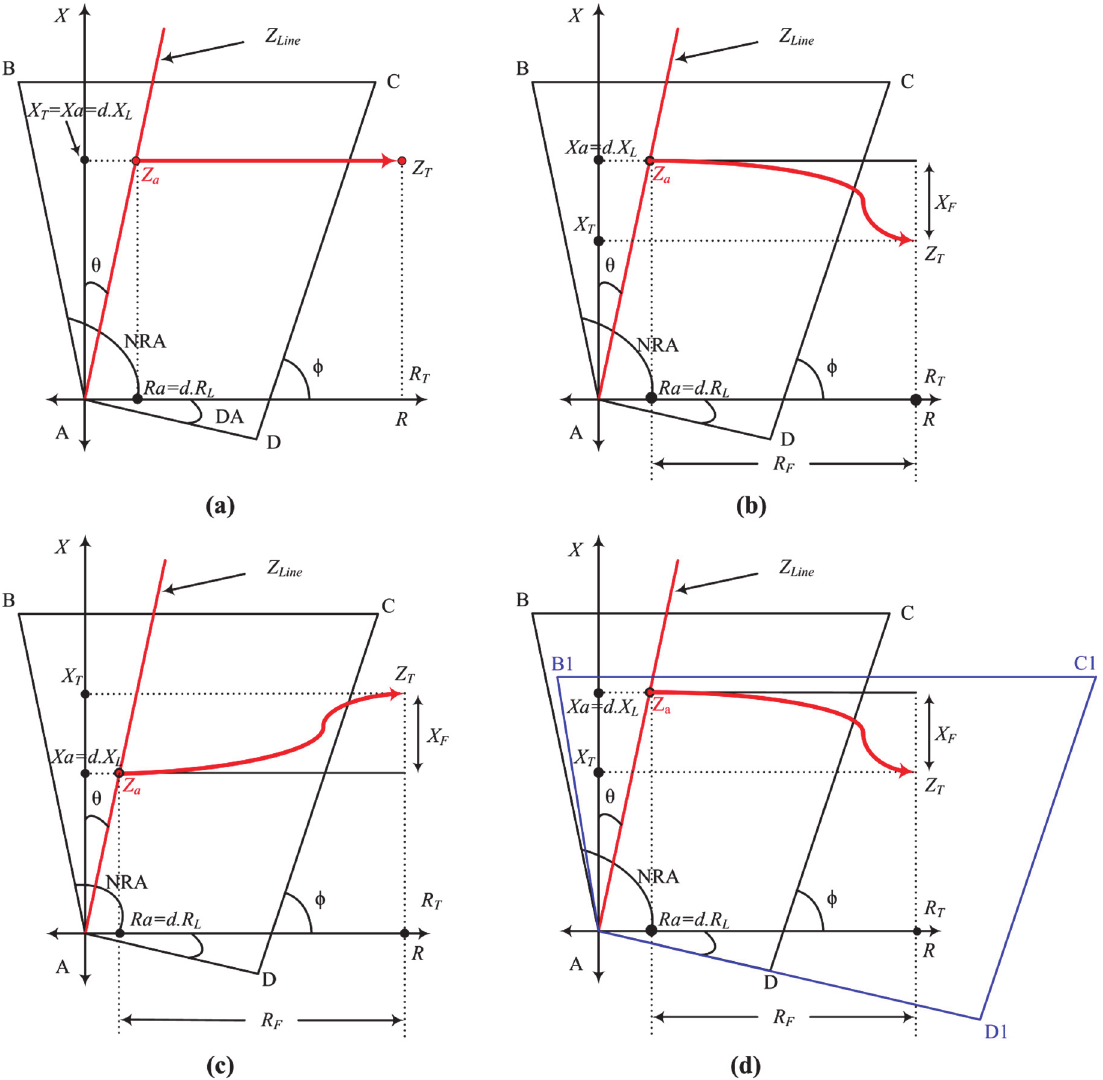
Fig. 6. Impedance trajectory Z T during variable fault resistance R F for different power flow conditions between SEB & MEB: (a) no power transfer; (b) exporting power flow; (c) importing power flow; and (d) adaptive characteristic during variable power